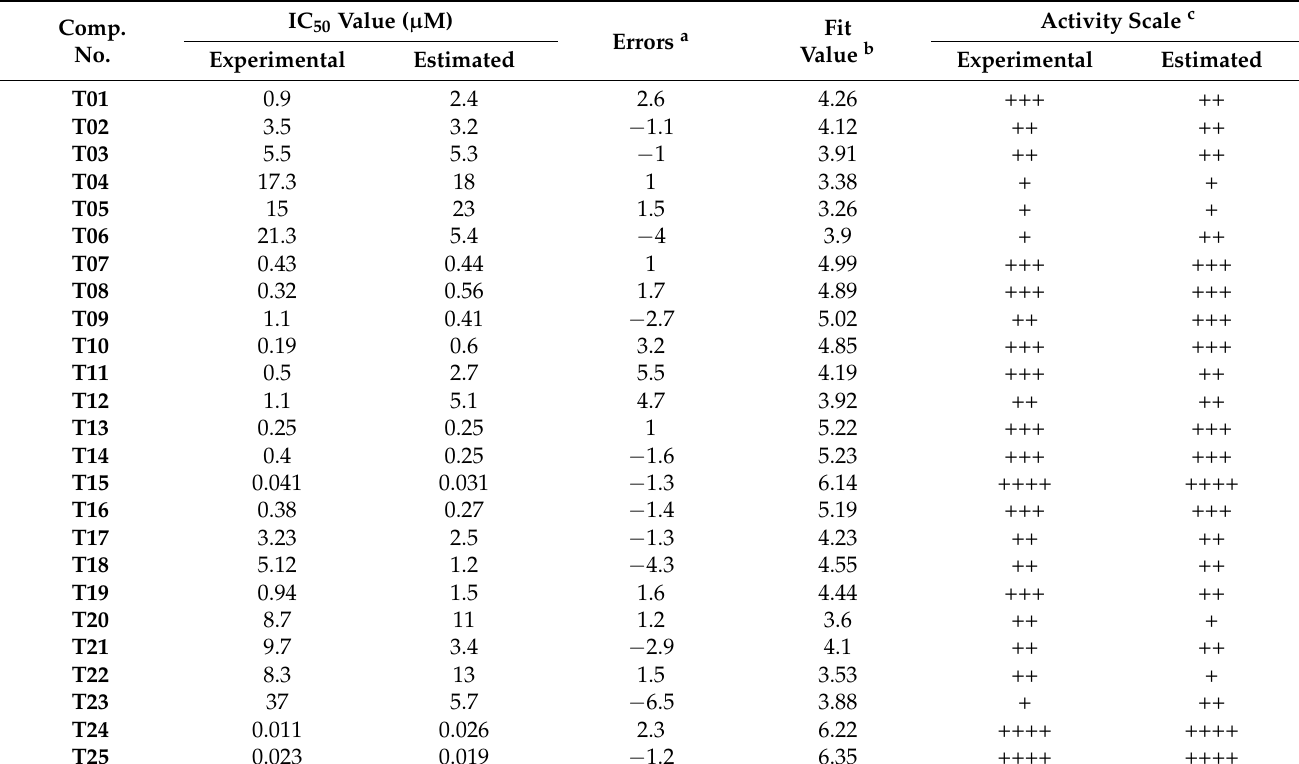
Table 2. Experimental and Estimate activity of the training set compounds based on pharmacophore Hypo1. Comp.